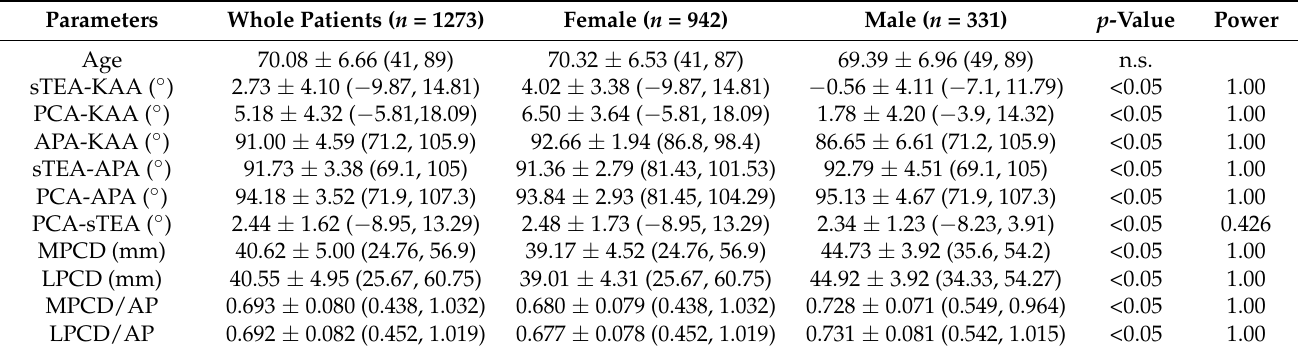
Table 1. Comparison of measurements according to gender.